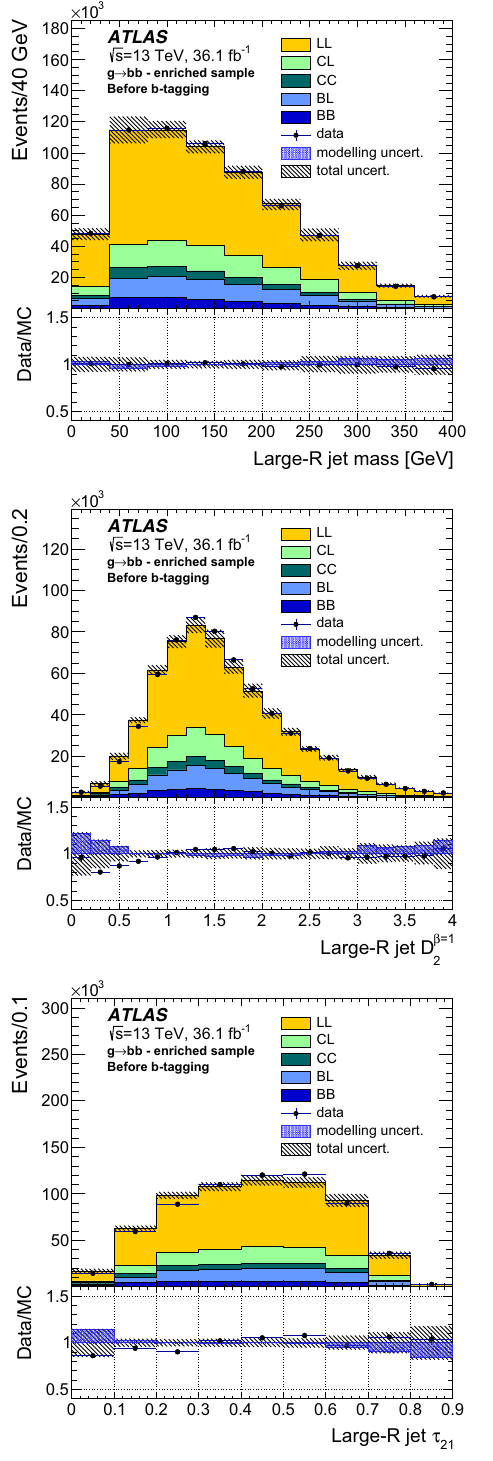
β = 1 uncertainty includes all systematic uncertainties listed in Sect. 5 and (middle) and τ 21 2 the fit uncertainty summed in quadrature. The D tainty bands include additional substructure variable uncertainties